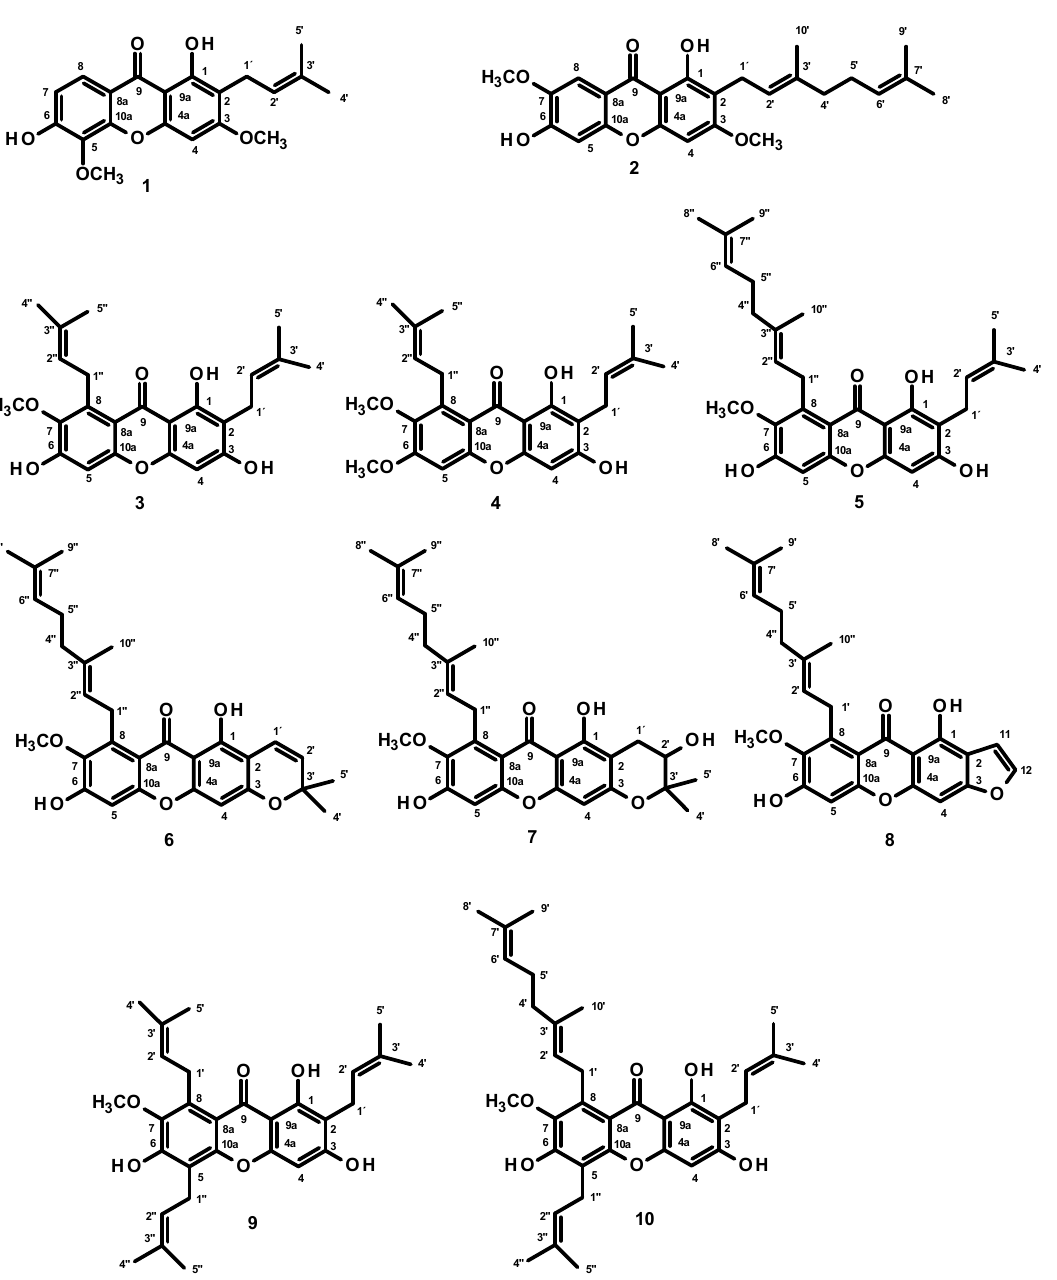
Figure 1. Prenylated xanthones isolated from the extract of the bark resin of G. nigrolineata Planch.ex T. Anderson.